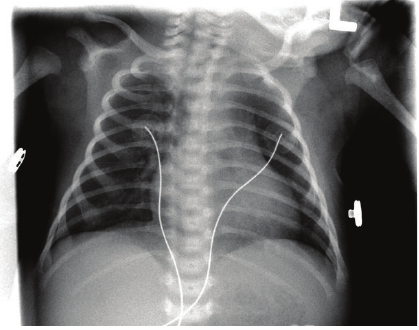
Figure 5: Frontal view of the chest shows complete resolution of PIE, pneumothorax, and pneumomediastinum.